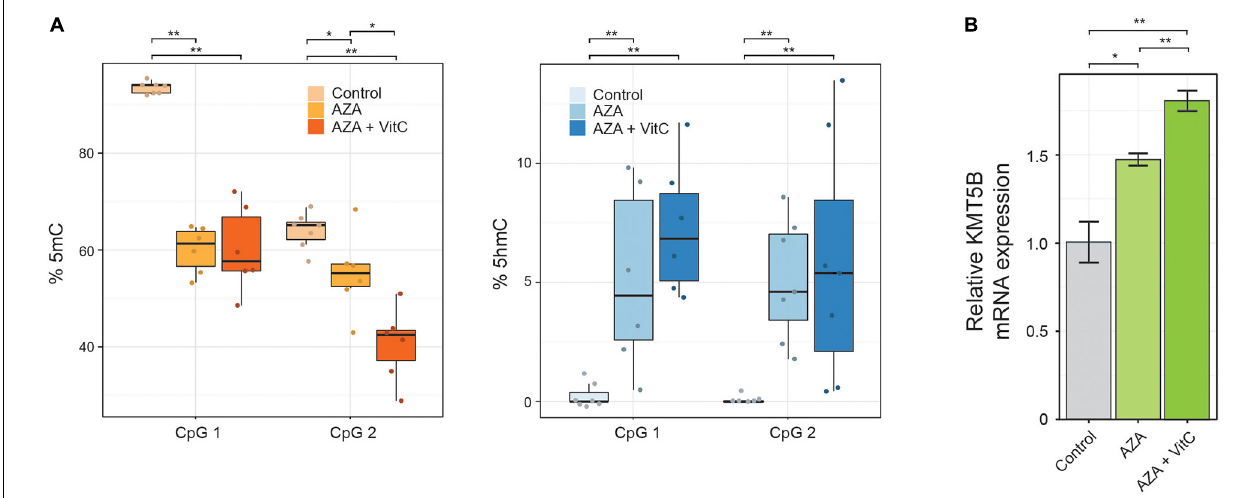
FIGURE 2 | Pharmacological restoration of 5mC/5hmC levels in human GBM cell line LN-229. Cells were treated with demethylating agent 5-AZA-dC, either alone or in combination with vitamin C (Vit C). The effects on 5mC/5hmC levels and on KMT5B expression were assessed by (A) bisulfite pyrosequencing at two intragenic CpG positions (Wilcoxon rank sum test; * p < 0.05; ** p < 0.01) and (B) KMT5B mRNA relative expression by means of qRT-PCR. The data are the average ± SEM of three independent experiments (Welch t -test; * p < 0.05; ** p <